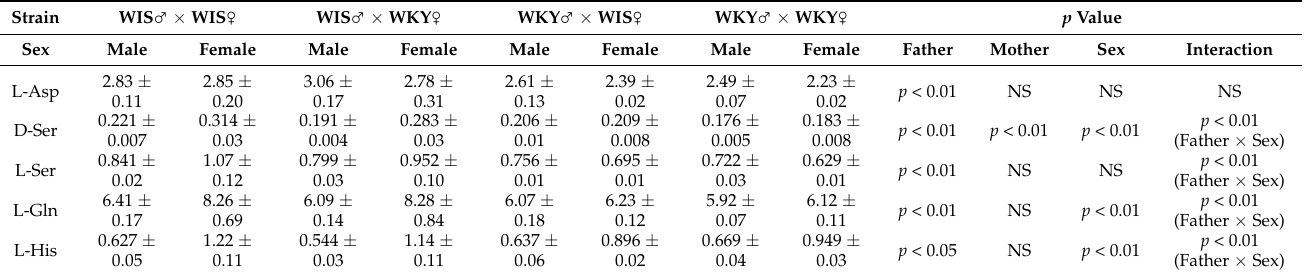
Table 3. Effect of paternal or maternal strain and sex of offspring on free amino acid concentration in the